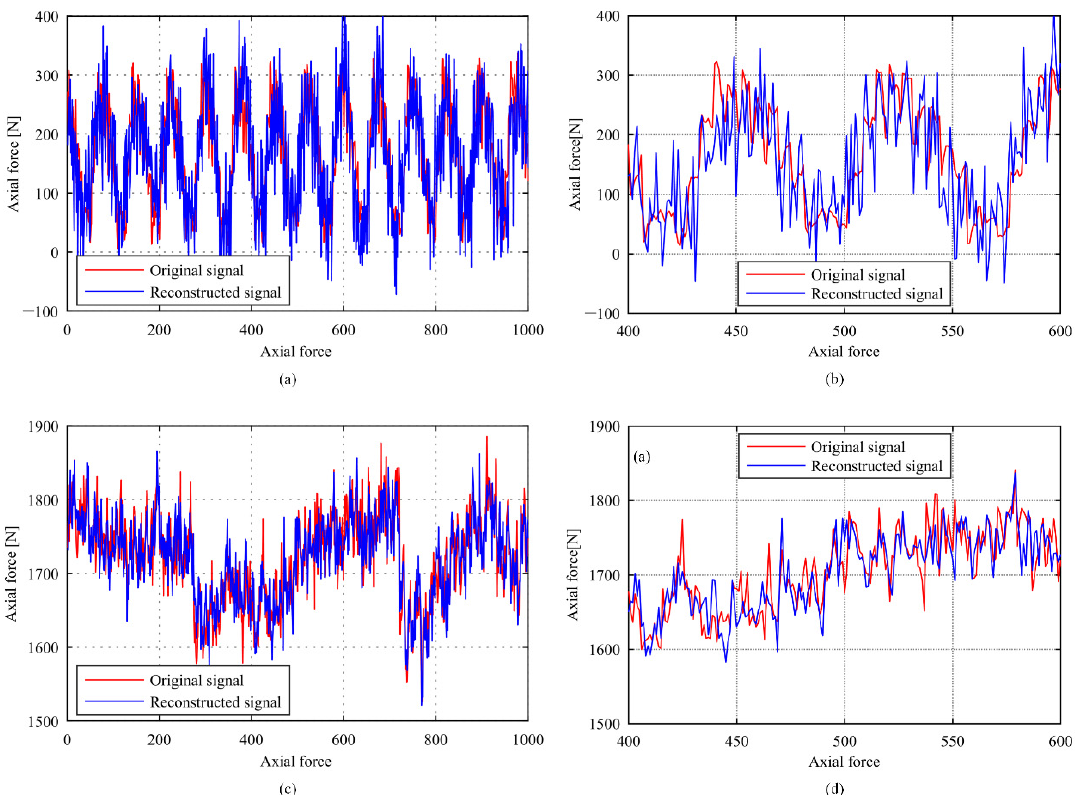
Figure 6. Reconstruction effect comparison of ( a ) milling force, ( b ) local enlarged view of milling force, ( c ) drilling force and ( d ) local enlarged view of drilling force. force, ( c ) drilling force and ( d ) local enlarged view of drilling